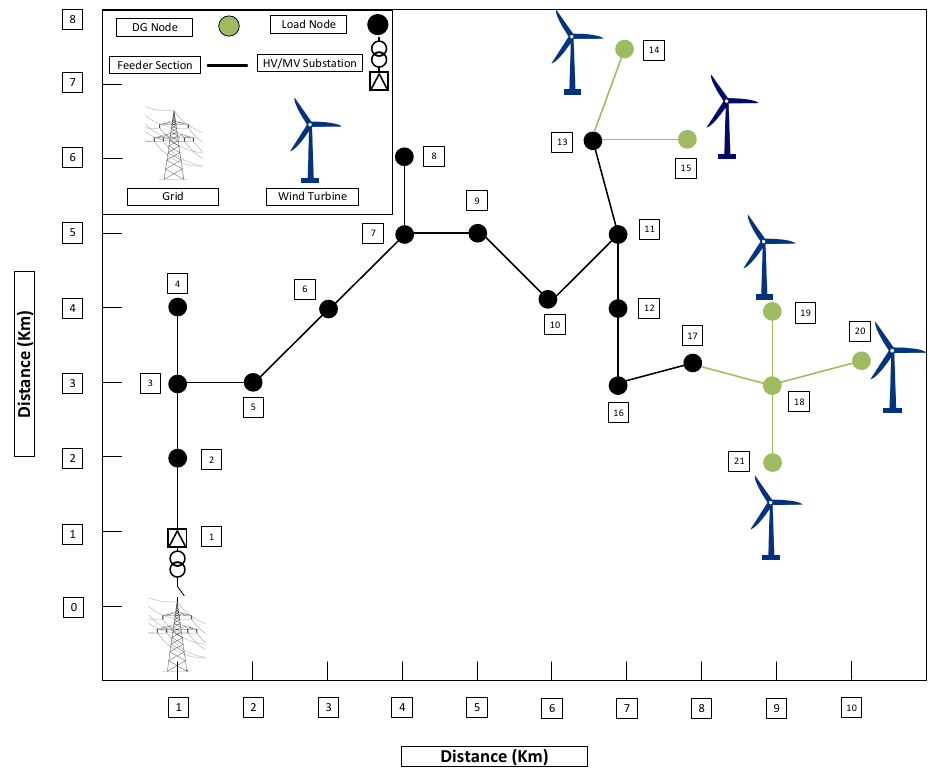
Figure 8. Distribution network configuration. Table 2. Parameters of the Sample Network.